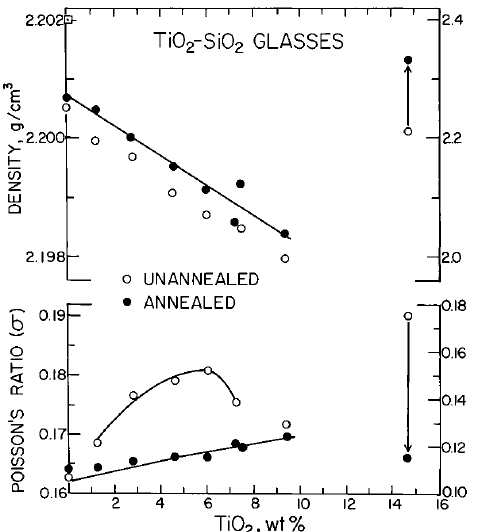
Figure 2. Density ( ρ ) and Poisson’s ratio ( σ ) versus TiO 2 content. As shown, annealing causes an increase in ρ and decrease in σ for the SiO 2 –TiO 2 glasses studied.